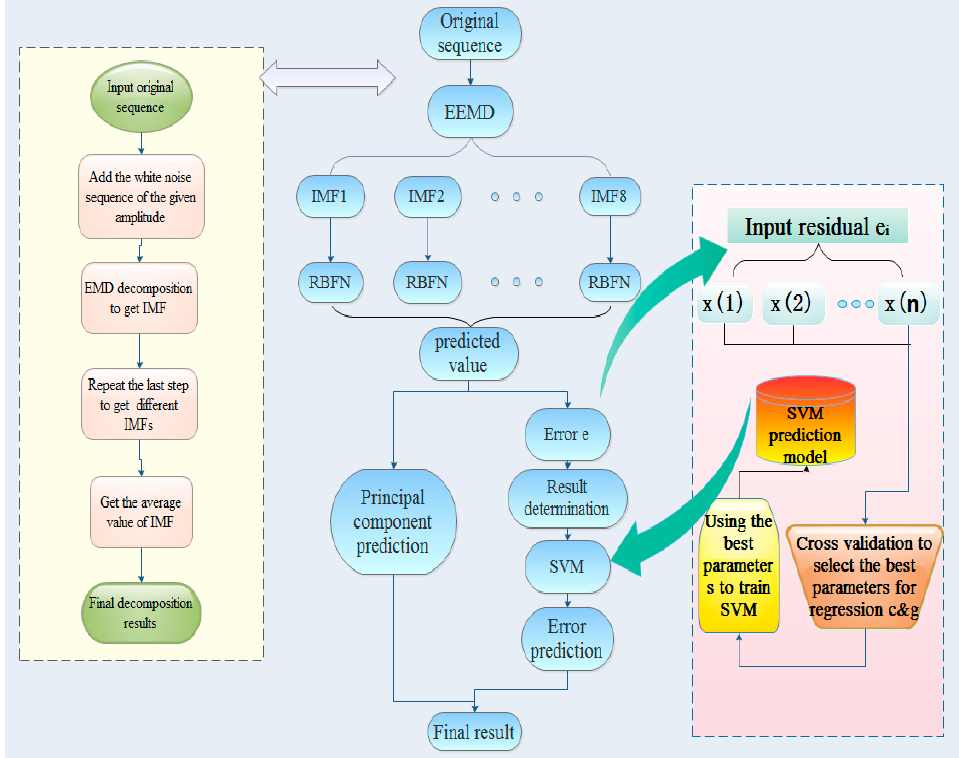
Figure 3. The overall framework of the hybrid EEM–RBFN–SVM model.